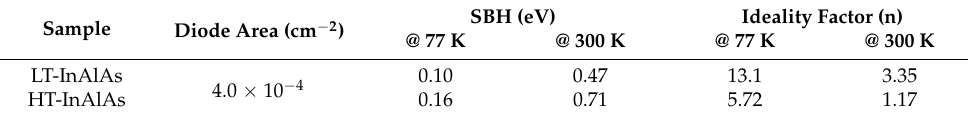
Table 1. Calculated values of SBH and ideality factor n from Figure 6 (fitted between 0.1 to 0.4 V).